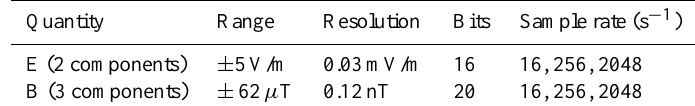
Table 1. Summary of measured quantities